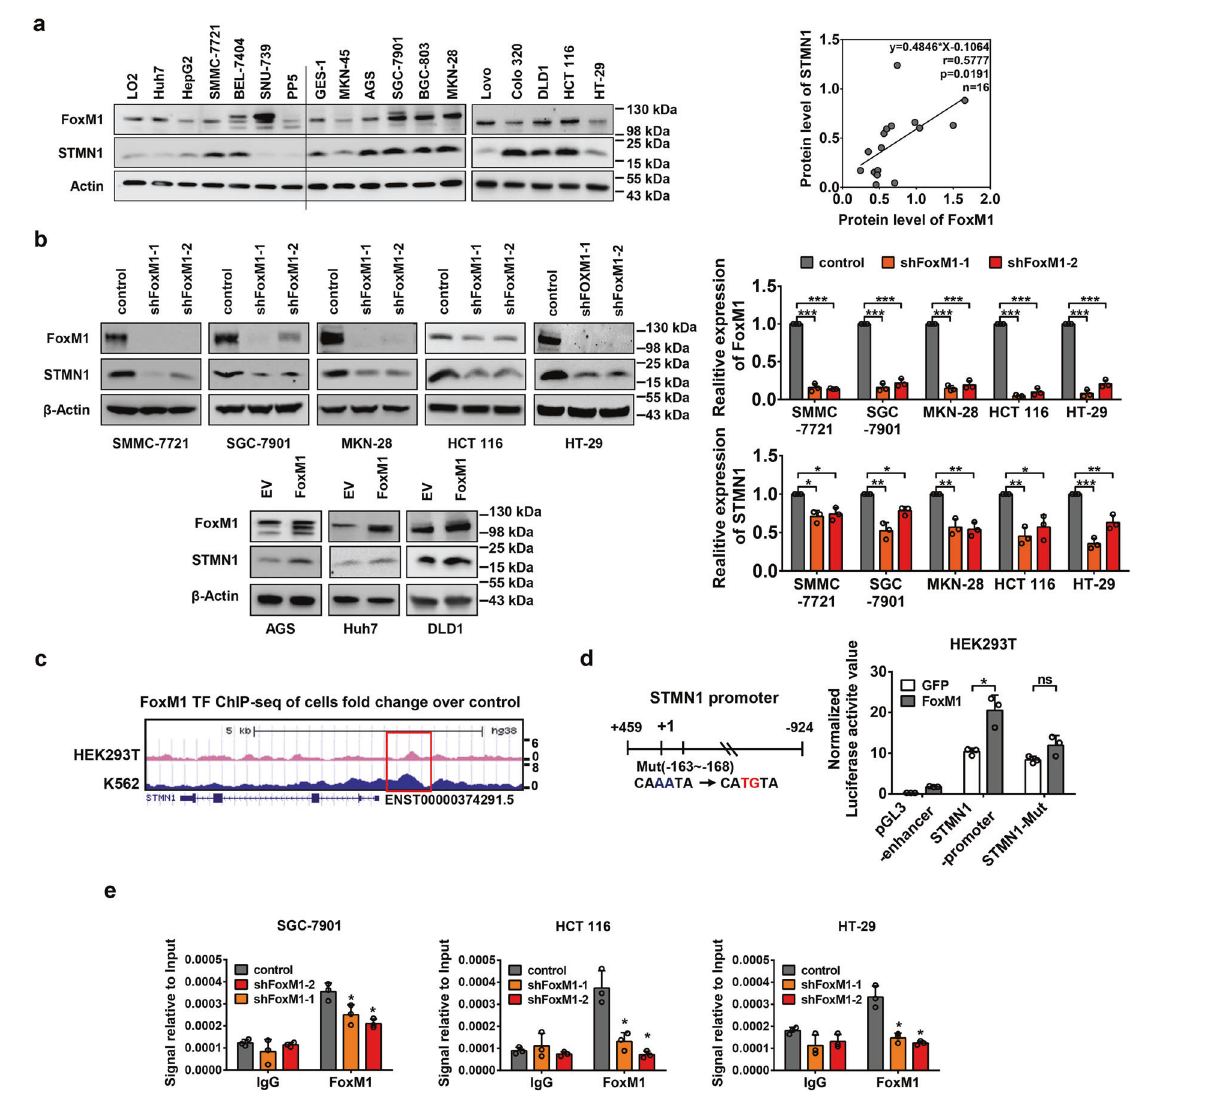
Fig. 2 FoxM1 transcriptionally activates STMN1 in cancer cells. a The expression of FoxM1 and STMN1 in six hepatocellular carcinoma cell lines, fi ve gastric cancer cell lines, fi ve colorectal cancer cell lines, a human hepatocyte cell line LO2 and a human gastric mucosal epithelial cell line GES-1. The gray density analysis for the data of Western blot was done by using ImageJ software, and the correlation of FoxM1 and STMN1 expression was analyzed in the above 16 cell lines, excepting an LIHC cell line SNU-739 and a CRC cell line Colo-320. b The hepatocellular carcinoma cell line SMMC-7721, gastric cancer cell lines SGC-7901 and MKN-28, colorectal cancer cell lines HCT 116 and HT-29 were used to established FoxM1-knockdown cells by lentivirus-mediated shRNA delivery system. The human hepatocellular carcinoma cell line Huh7, gastric cancer cell line AGS and colorectal cancer DLD-1 were used to establish FoxM1-overexpressed cells by lentivirus infection. The protein levels of FoxM1 and STMN1 were detected using Western blot. The qRT-PCR assay was performed to detect the mRNA expression of STMN1 in FoxM1-knockdown or -overexpressed cells. The data were presented as the mean ± SD of three independent experiments. The signi fi cance was analyzed by the Student ’ s t -test. * P < 0.05, ** P < 0.01, *** P < 0.001. c Analysis of the ChIP-seq data of FoxM1 in HEK293T and K562 cells from the ENCODE database, respectively. The red box shows the binding peaks of FoxM1 on the STMN1 genomic locus. d Dual luciferase reporter assay of FoxM1 and STMN1 promoter or its mutation. The binding site of FoxM1 is in the transcription start site of − 163 ~ − 168. The data were presented as the mean ± SD of three independent experiments. The signi fi cance was analyzed by the Student ’ s t -test. * P < 0.05. e The ChIP-qPCR was used to determine the direct binding of FoxM1 on the promoter region of STMN1 in SGC-7901, HCT 116 and HT- 29 cell lines. Primers located on the upstream of STMN1 transcript start site ( − 2893 ~ − 3000) was designed for a negative control. The data were presented as the mean ± SD of three independent experiments. The signi fi cance was analyzed by the Student ’ s t -test. * P < 0.05 Signal Transduction and Targeted Therapy (2021)